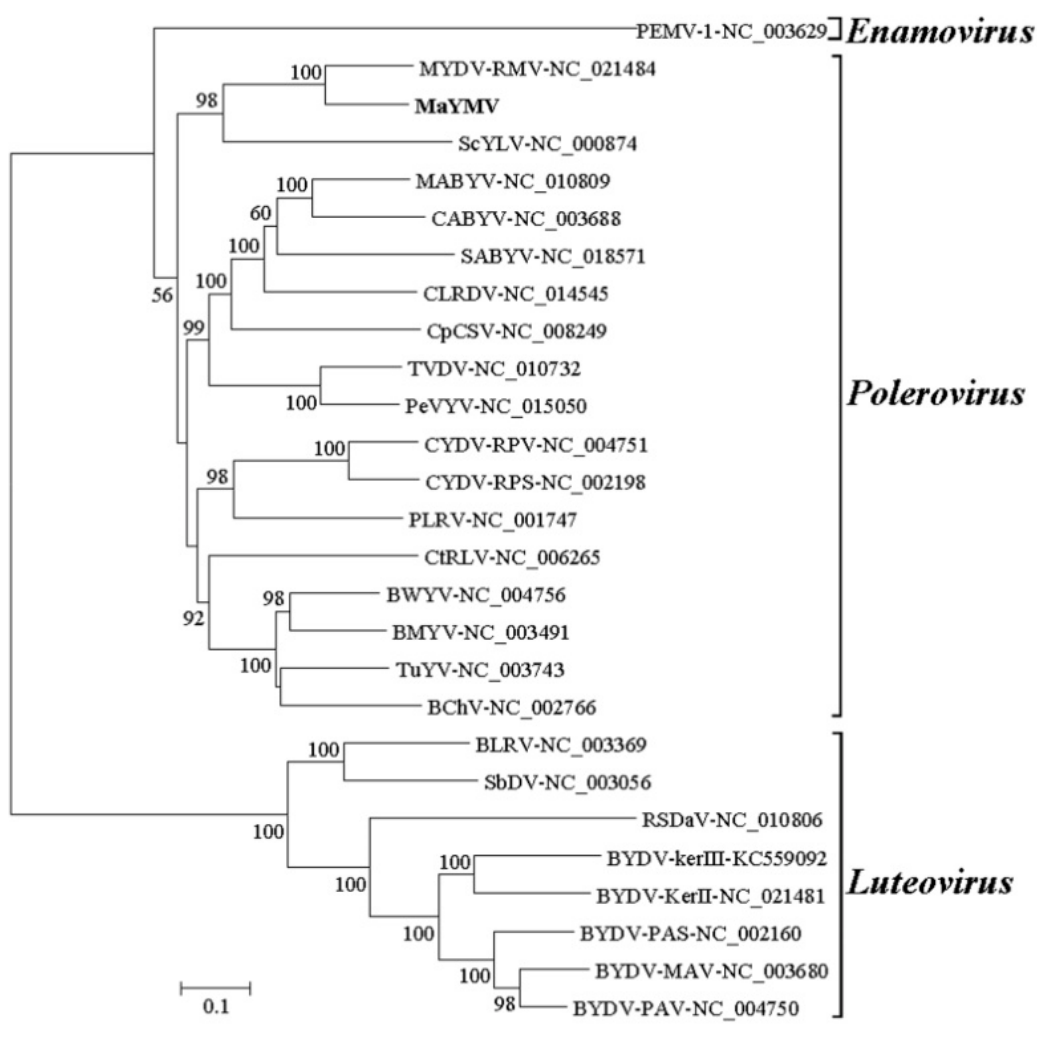
Figure 3. Phylogenetic analyses of MaYMV and selected luteoviruses based on complete genome sequences. The phylogenetic trees were generated using the neighbor-joining method and MEGA6 software. The percentage of replicate trees in which the associated taxa clustered together in the bootstrap test (1000 replicates) is shown next to the branches.